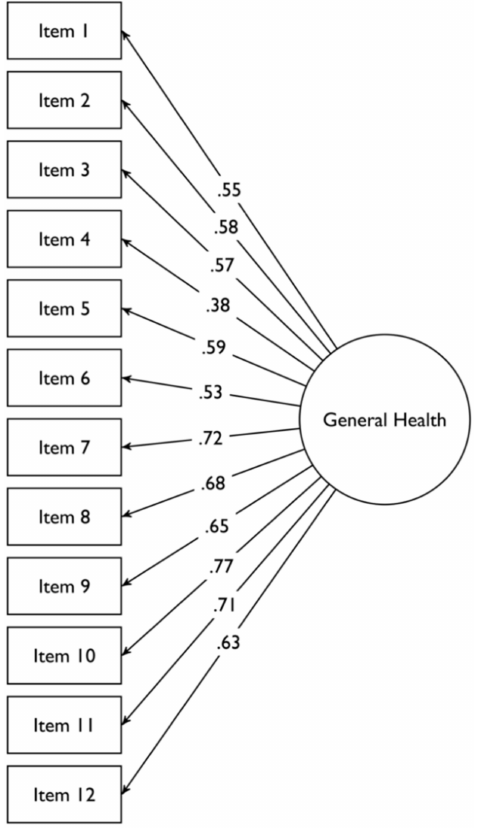
Figure A3. Factor structure of the General Health